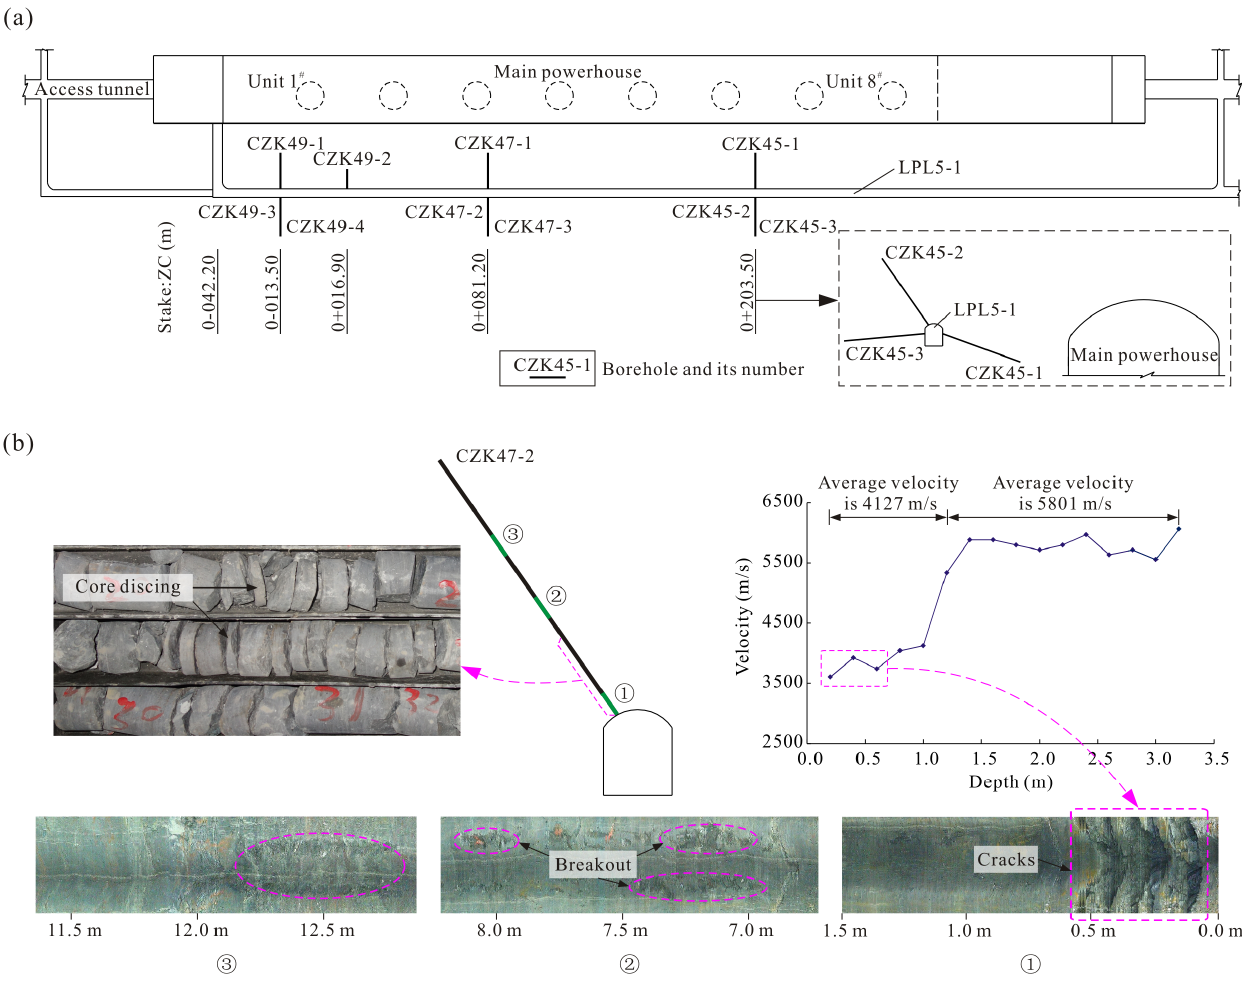
Figure 6. Field investigation and results: ( a ) layout of survey sections and boreholes from top view and axial view and ( b ) digital borehole camera images, cores and acoustic wave velocity curve at the upstream spandrel of drainage gallery LPL5-1.